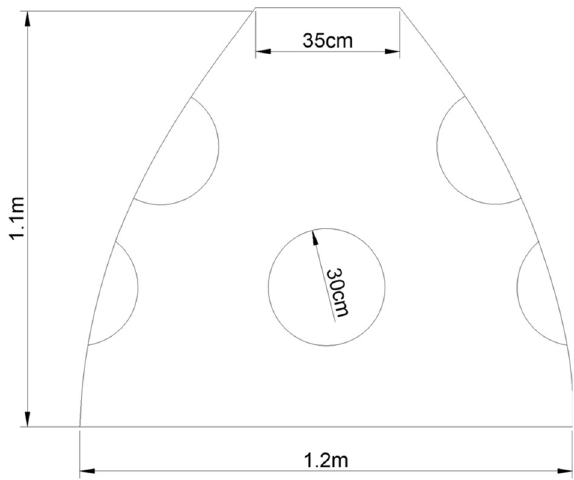
Figure 8. Outline diagram of ABR